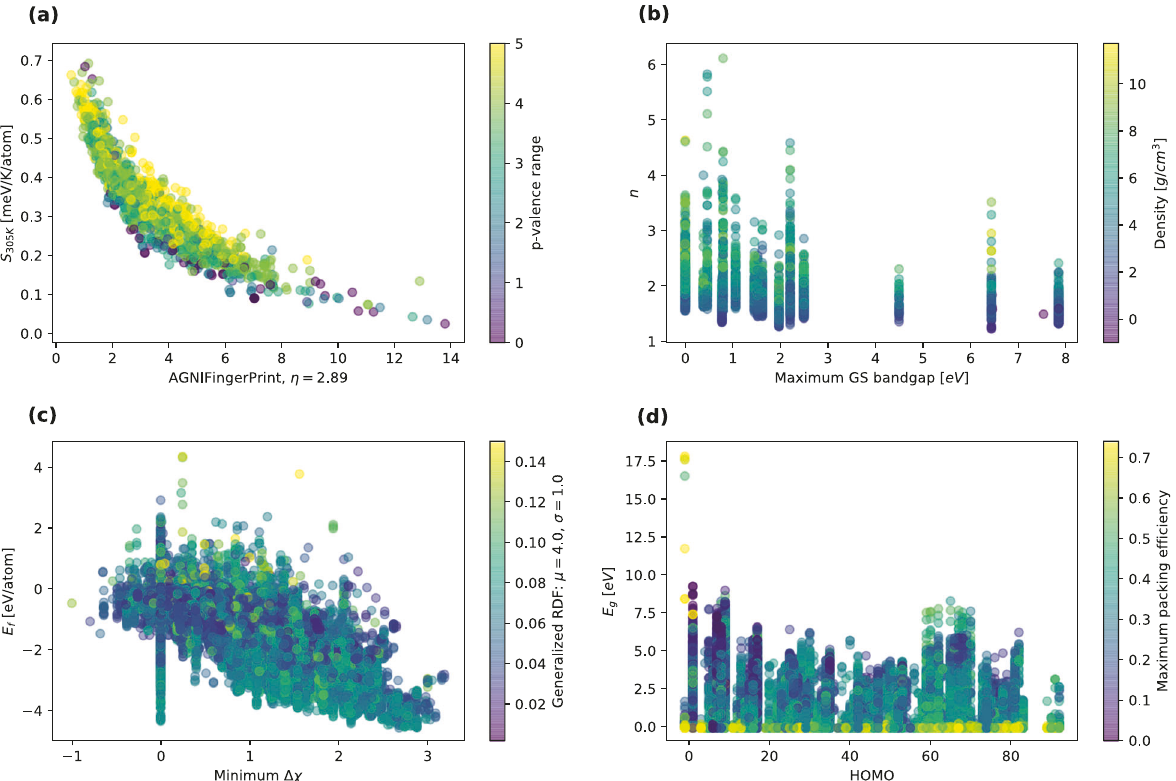
Fig. 4 Visualization of selected features. Bivariate representation of the two most important features for four different properties: ( a ) vibrational entropy at 305 K, ( b ) refractive index, ( c ) formation energy, and ( d ) band gap energy. Both features are complementary to narrow down the target output, although certainly not suf fi cient for an accurate